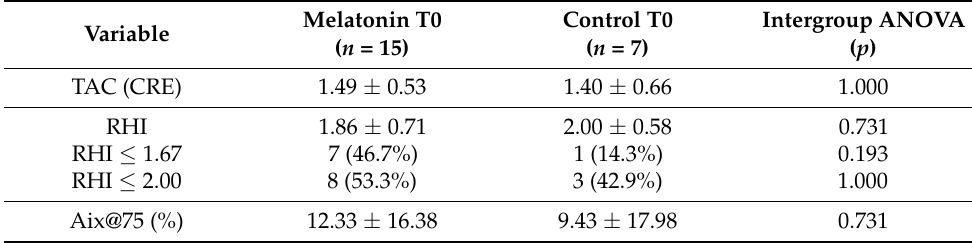
Table 2. Baseline evaluation (T0) of total antioxidant capacity (TAC), endothelial function with non- invasive method (EndoPAT), and peripheral plethysmography for the evaluation of indices of arterial stiffness (SphygmoCor) in both melatonin and control group. Data are expressed as mean ± standard deviation